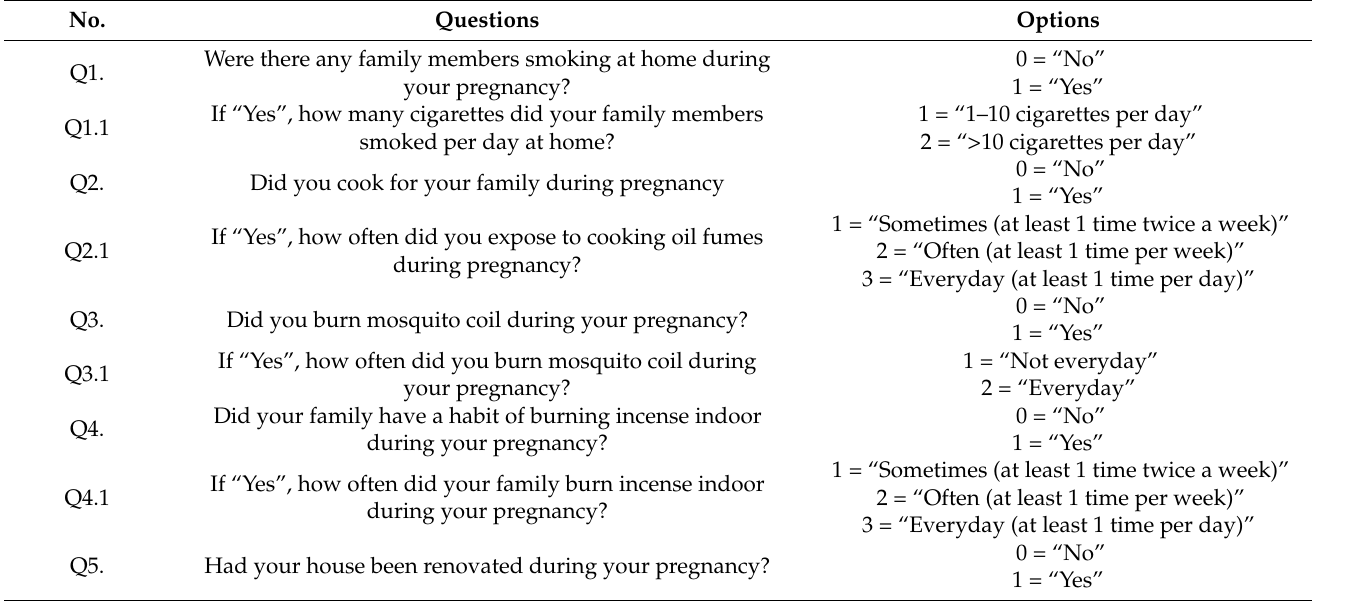
Table 1. Questions and options regarding prenatal HAP